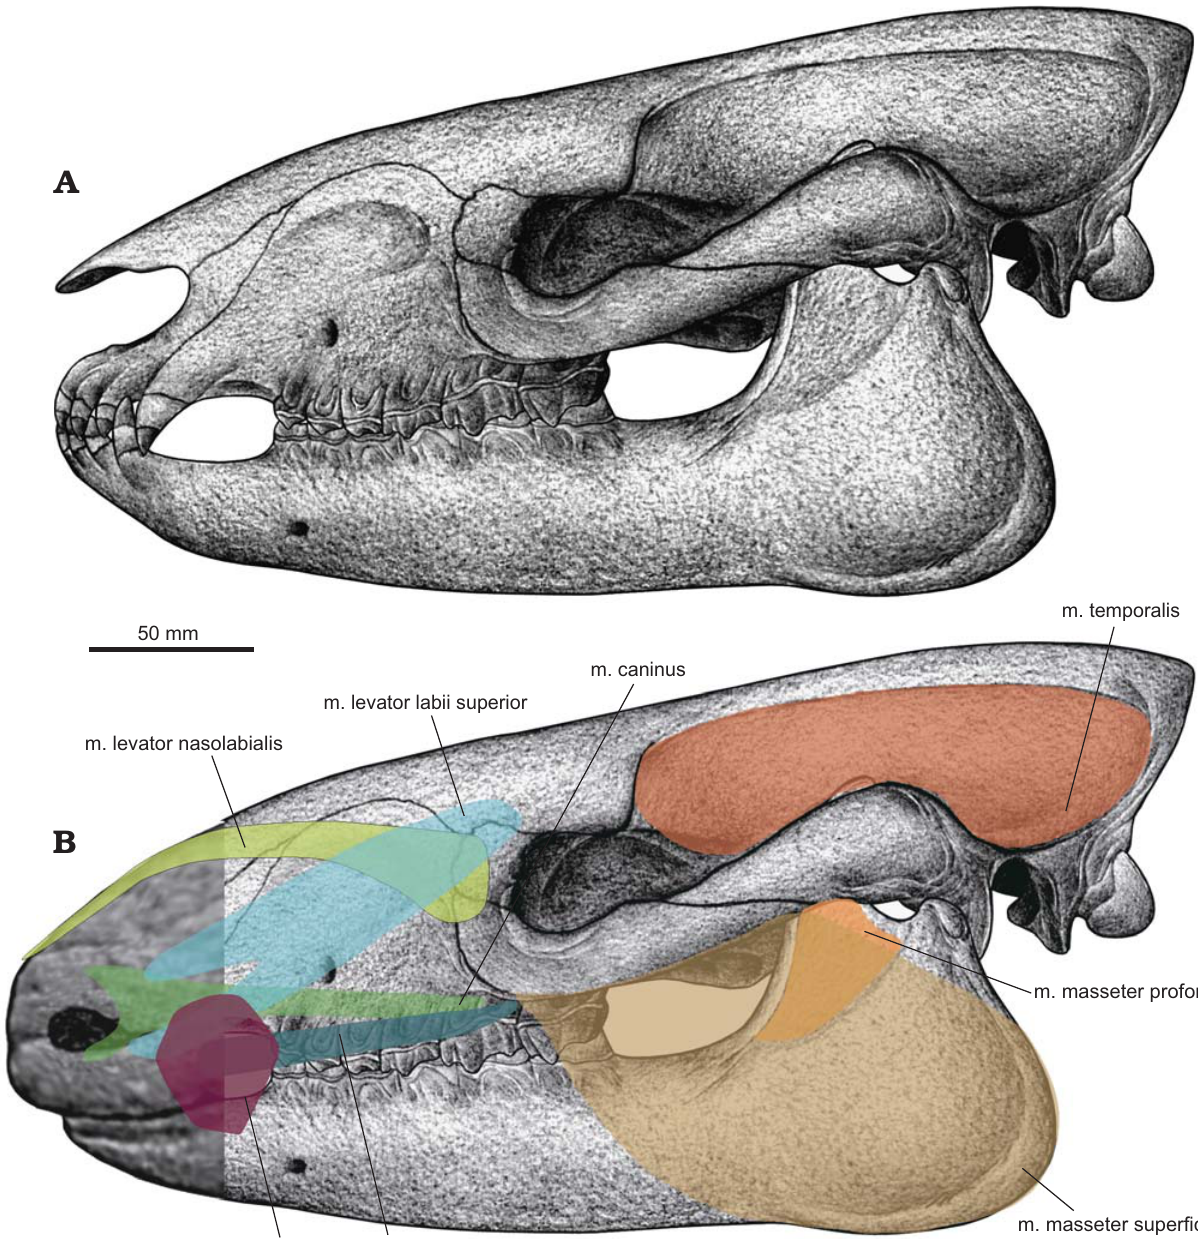
Fig. 4. Illustration of the cranial muscles in the paraceratheriid rhinocerotoid Pappaceras meiomenus in lateral view. A . Illustration of the cranium base on Wang et al. (2016). B . Interpretation of the reconstructed musculature; shaded area shows position of several facial muscles relative to the nose and